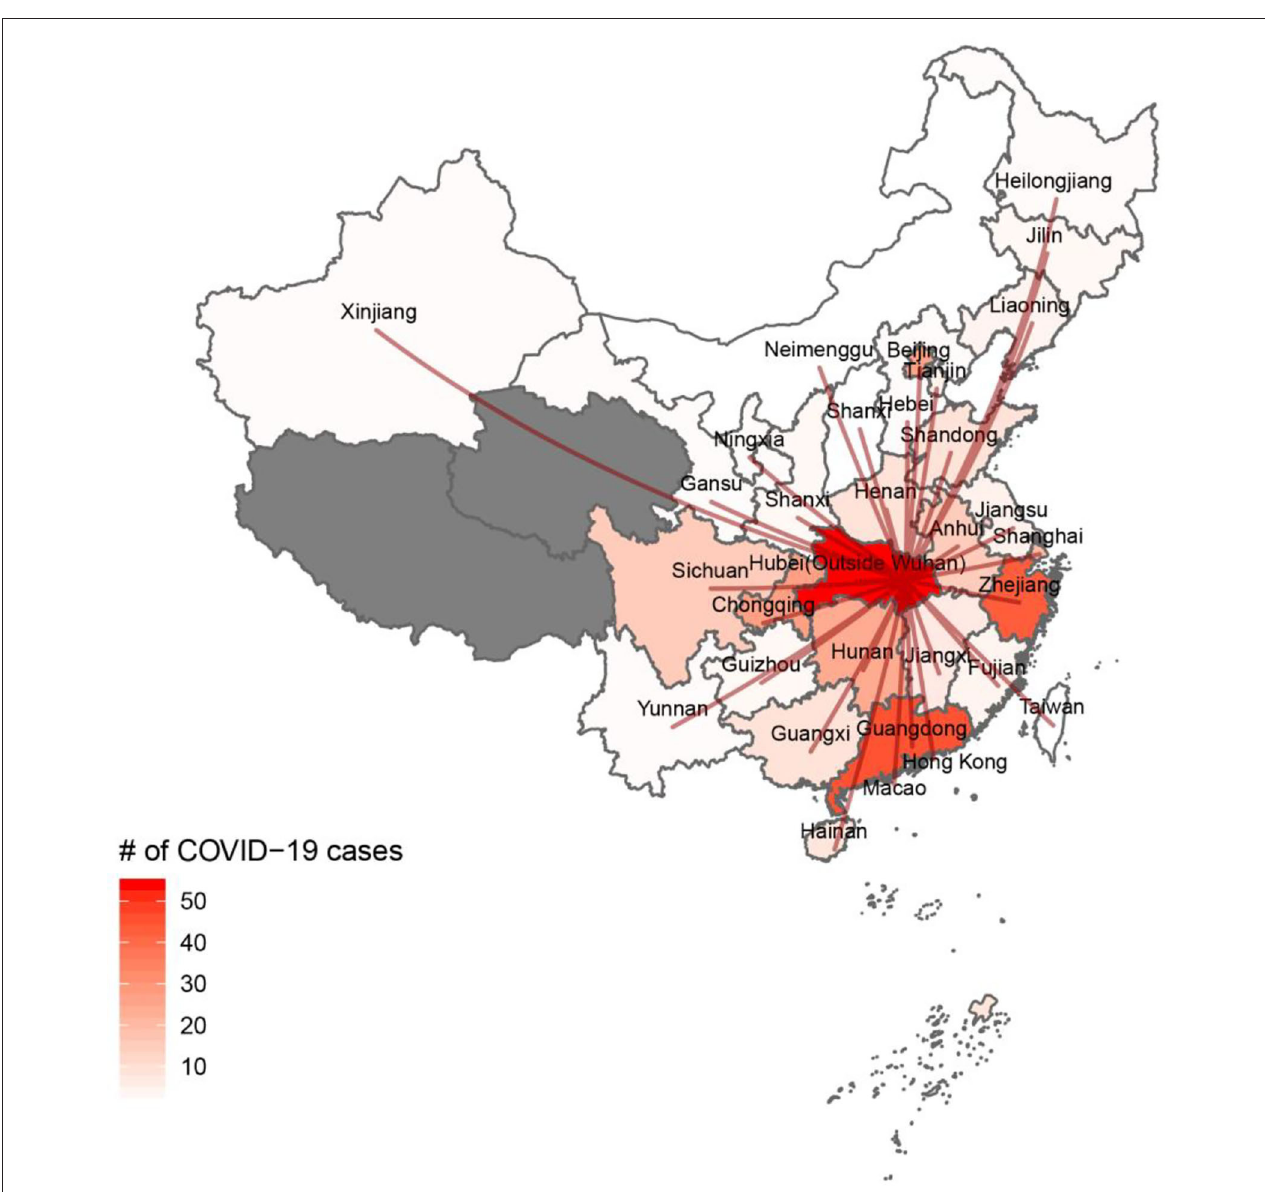
FIGURE 1 | The geographical distribution of exported COVID-19 cases in China. This figure reported number of reported COVID-19 cases in China, the dark gray area indicates the regions with zero COVID-19 cases as of 23 January 2020. Red paths show routes from Wuhan to other cities/regions.